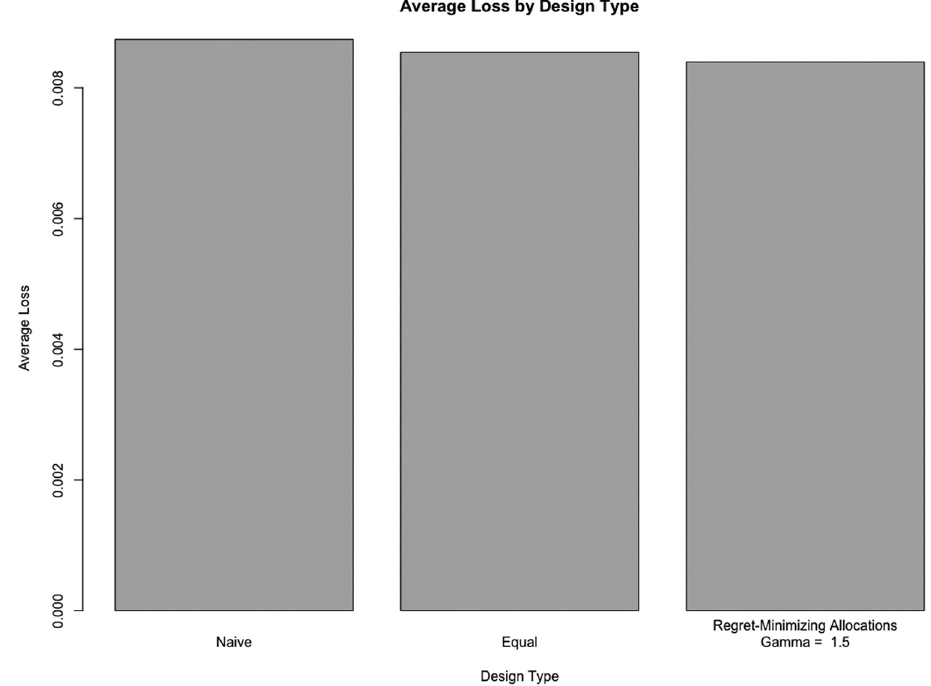
Figure 3: Average loss over 1,000 resamples of 1,000 - unit experiments under equal allocation, naïve allocation, and regret - minimizing allocation designs.